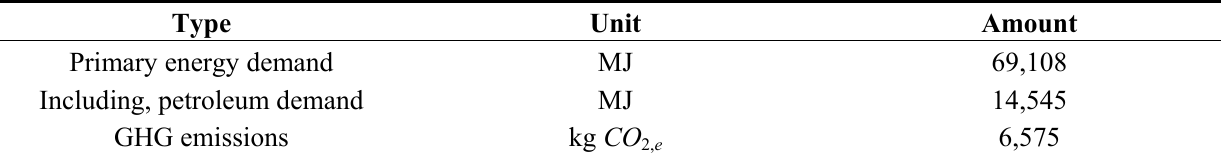
Table 8. Life cycle energy use and GHG emissions for the production of a medium-sized passenger car in China